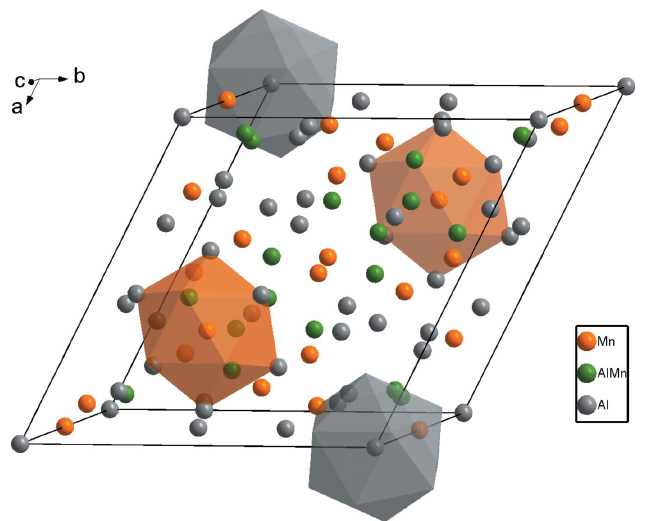
Figure 1 The crystal structure of Al 8.6 Mn 4.4 with two Mn02 atoms and two Al04 atoms displayed with their coordination environments as polyhedra.